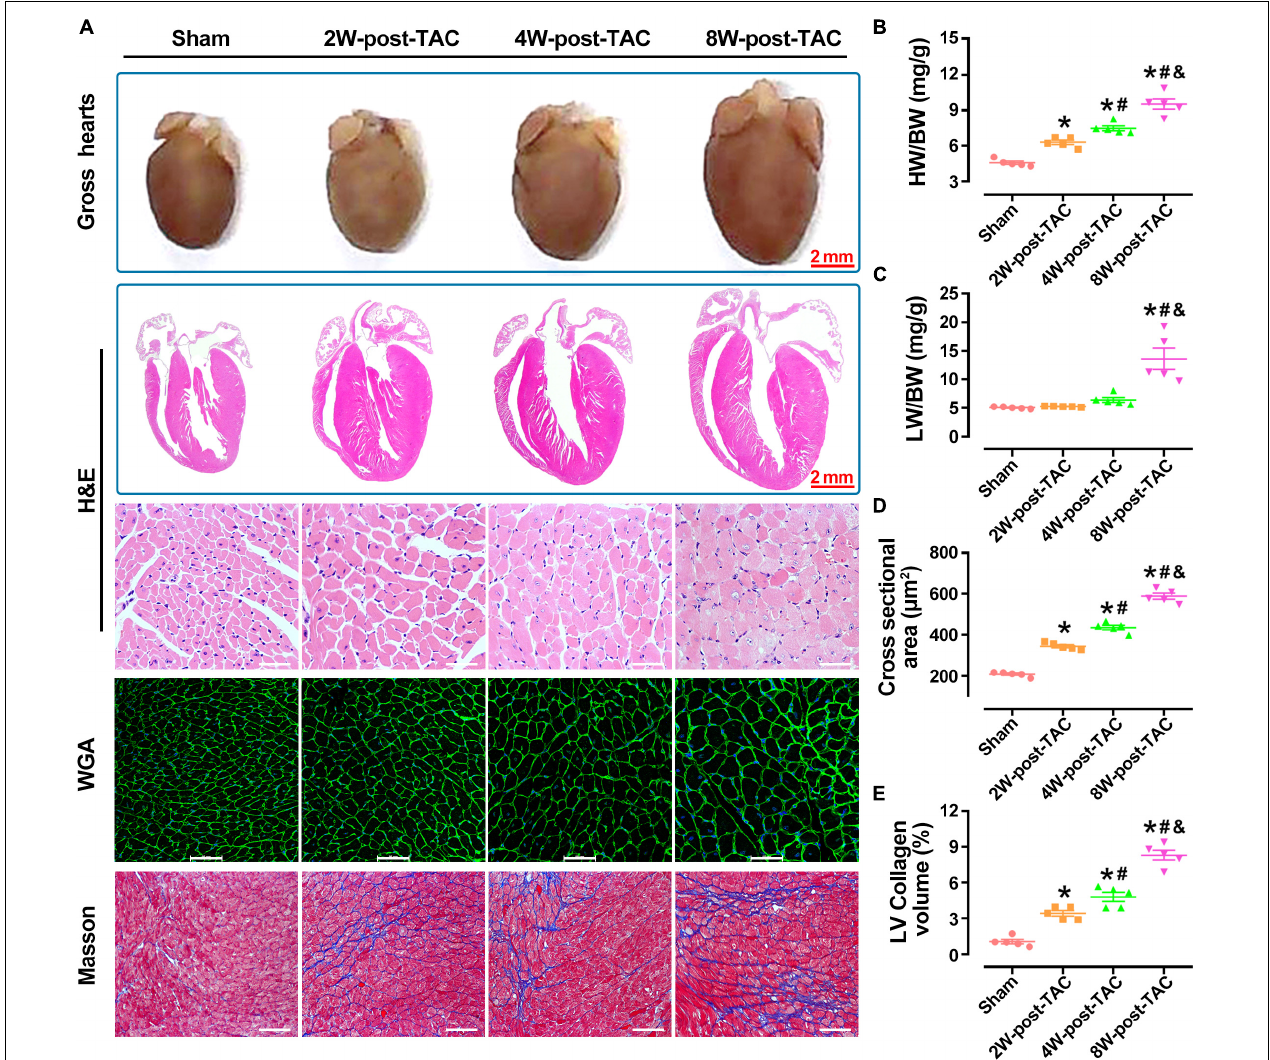
FIGURE 4 | Pathological changes in the three stages of heart failure. A pathological examination showed that the morphological changes in heart size were consistent with the B-mode echocardiographic measurements of the sham, 2W-, 4W-, and 8W-post-TAC groups (A) . In the 2W-post-TAC group, the hearts presented with concentric hypertrophy (A) and the heart weight:body weight ratios had gradually increased (B) . The lung weight:body ratios increased in the 8W-post-TAC group (C) . High magnification of the HE staining revealed that the cardiomyocytes were hypertrophic in the 2W-, 4W-, and 8W-post-TAC groups (A) . The WGA staining of the cardiomyocyte membranes confirmed that pressure overload-induced cardiomyocyte hypertrophy and cardiomyocyte size gradually increased with pressure overload (A,D) . Fibrosis in the left ventricles gradually increased as hearts progressed from the hypertrophic to the HFpEF to the HFrEF stages (E) . All data are presented as the means ± SEM. N = 5. * P < 0.05 vs. Sham, # P < 0.05 vs. 2W-post-TAC, and & P < 0.05 vs. 4W-post-TAC.